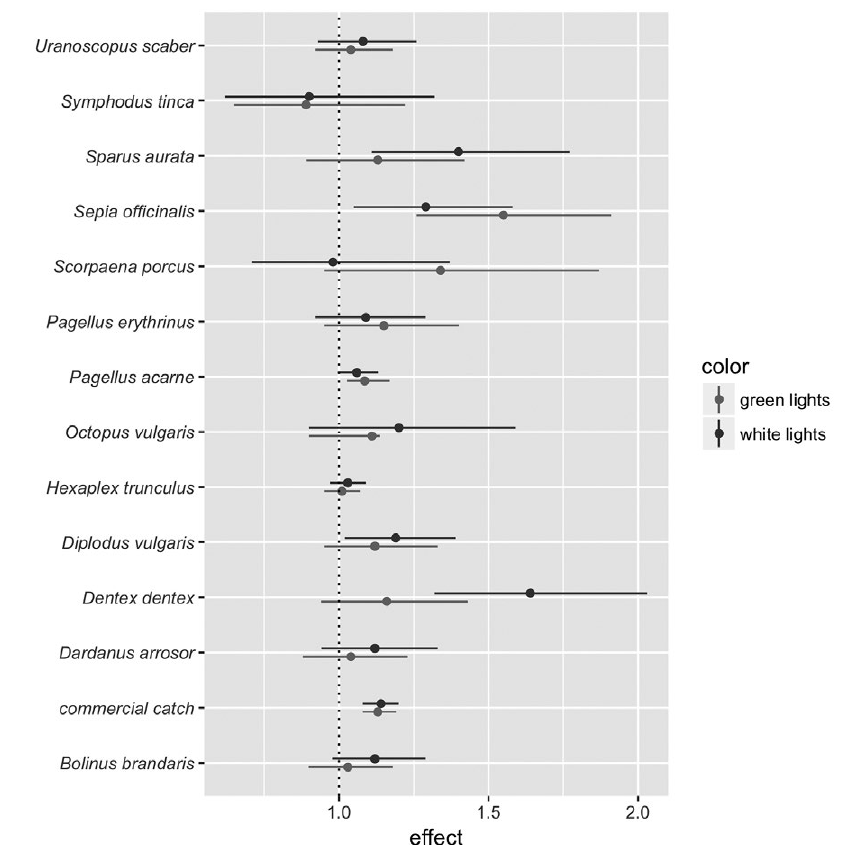
Fig. 3. – Relative measure of the effect of colour of lights mounted on the head rope on the catches of the main commercial species in cuttlefish trammel nets (average and 95% confidence interval). A value of 1 corresponds to no effect (i.e. catches in kg/100 m h of the modified net were not different from those of the standard net).